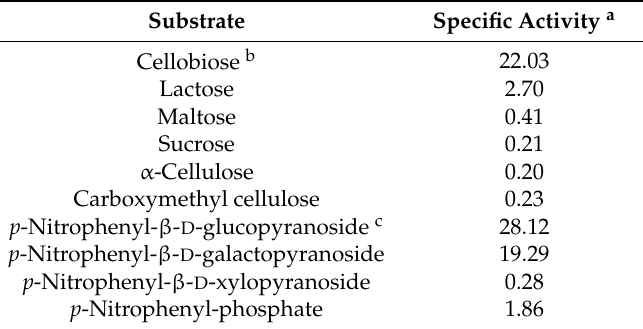
Table 3. The decomposition rates of flavonoids (as